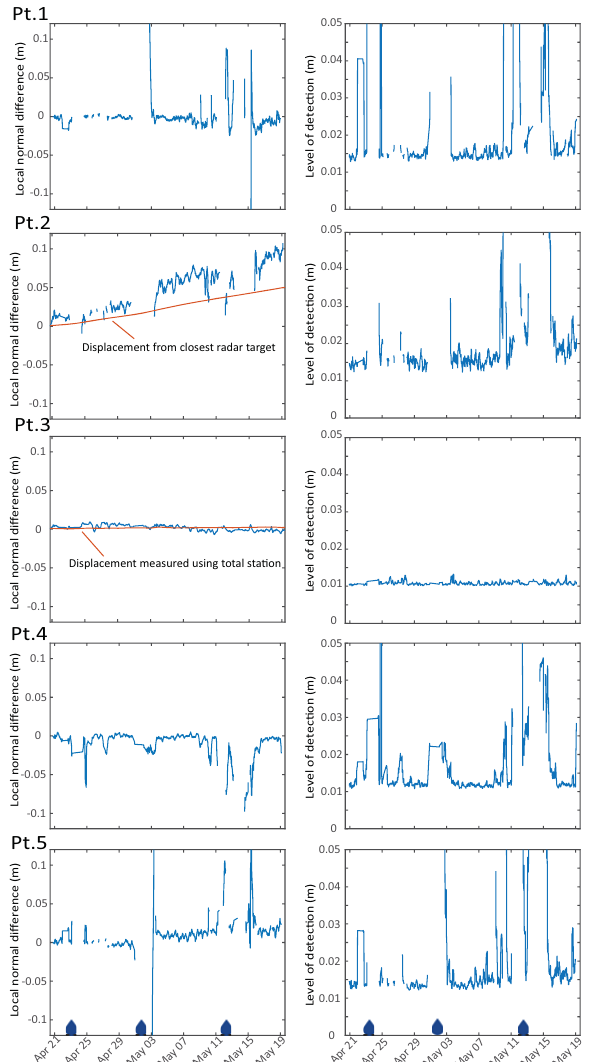
Figure 11. Distance and associated level of detection time series for points of interest 1 to 5 marked in Fig. 8. Point 1, 3 and 4 rep- resent areas of the slope with non-detectable change. Point 2 repre- sents the pre-failure deformation of a rockfall that occurred on the 16 June 2016 and Point 5 represents the deformation of the frontal zone of the landslide. Point 2 includes a comparison with measure- ments taken from the closest reference target and Point 3 includes a comparison with measurements taken with a total station for the same target